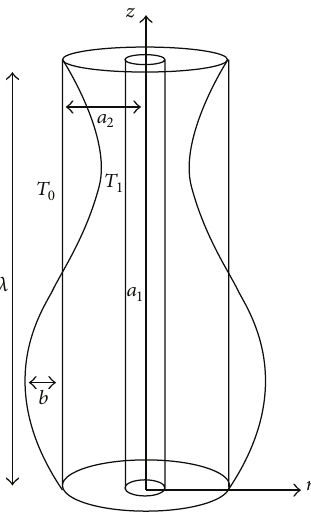
Figure 1: Geometry of the